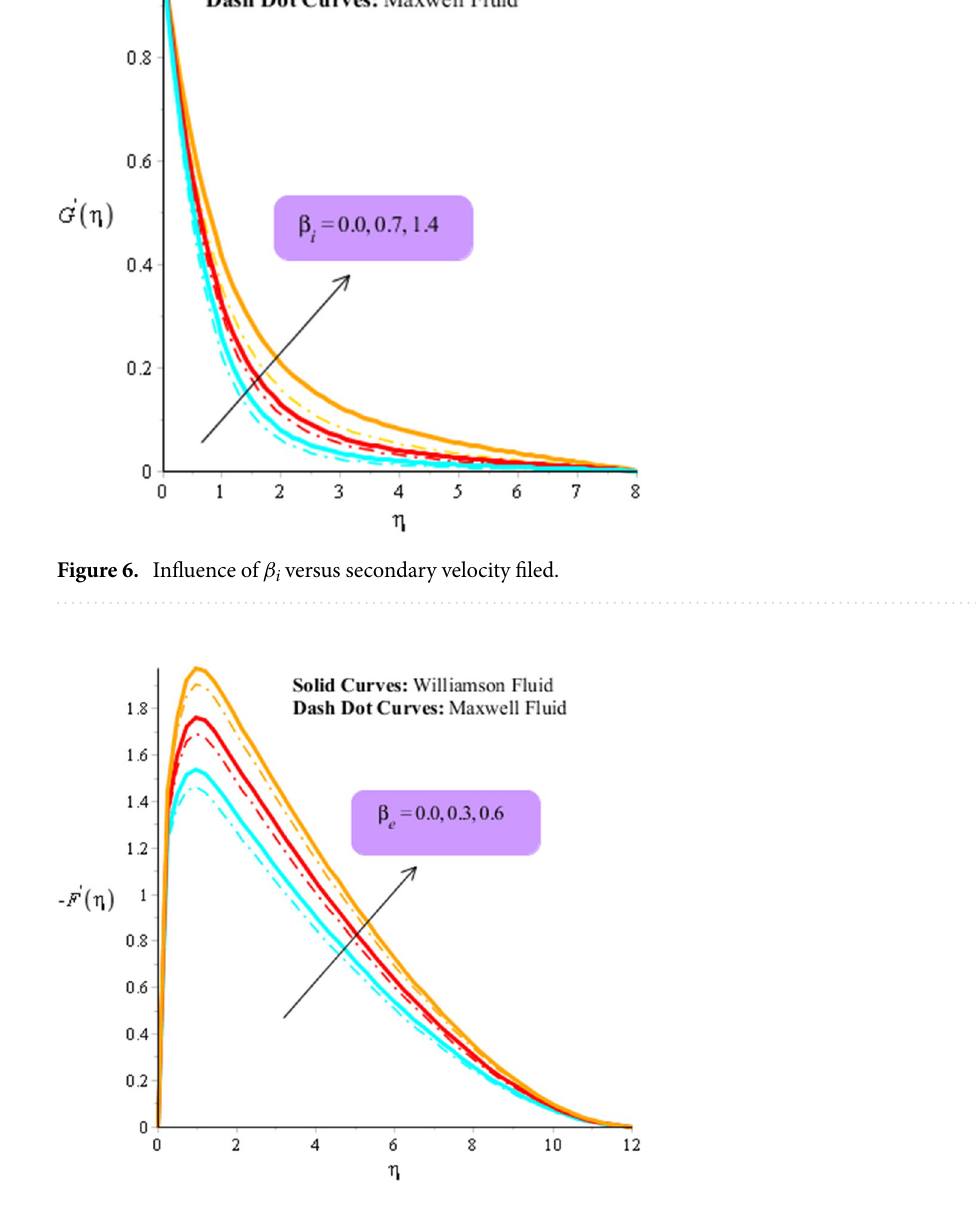
Figure 7. Influence of β e versus primary velocity